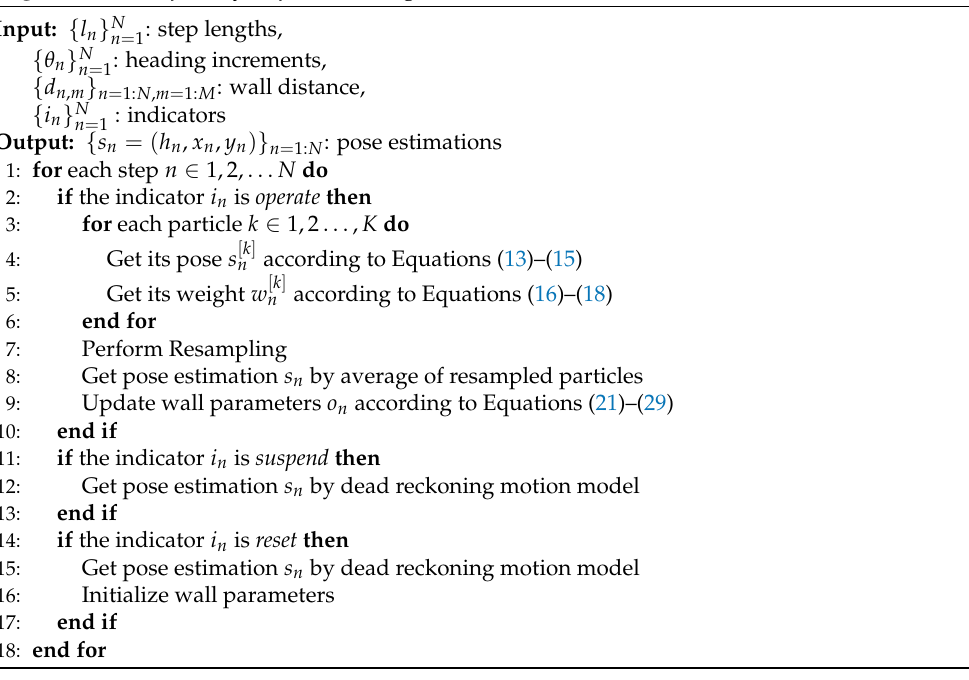
Algorithm 2 Trajectory adjustment algorithm